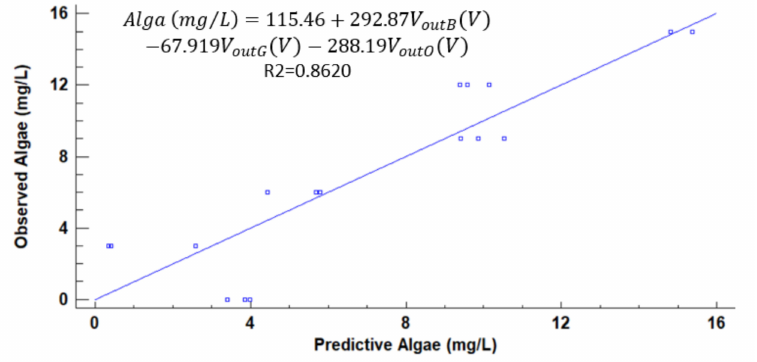
Figure 12. Observed vs. predicted values of algae concentration with a solid concentration of 15 mg/L.